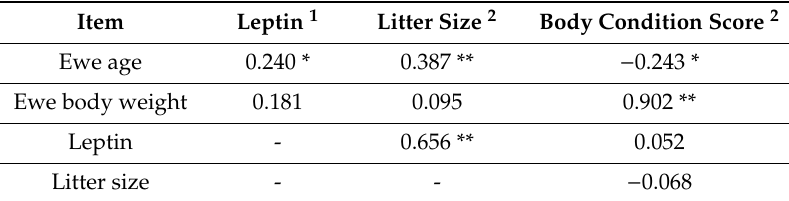
Table 3. Correlation of leptin concentration, litter size and body condition score with ewe age and ewe body weight. Item Leptin